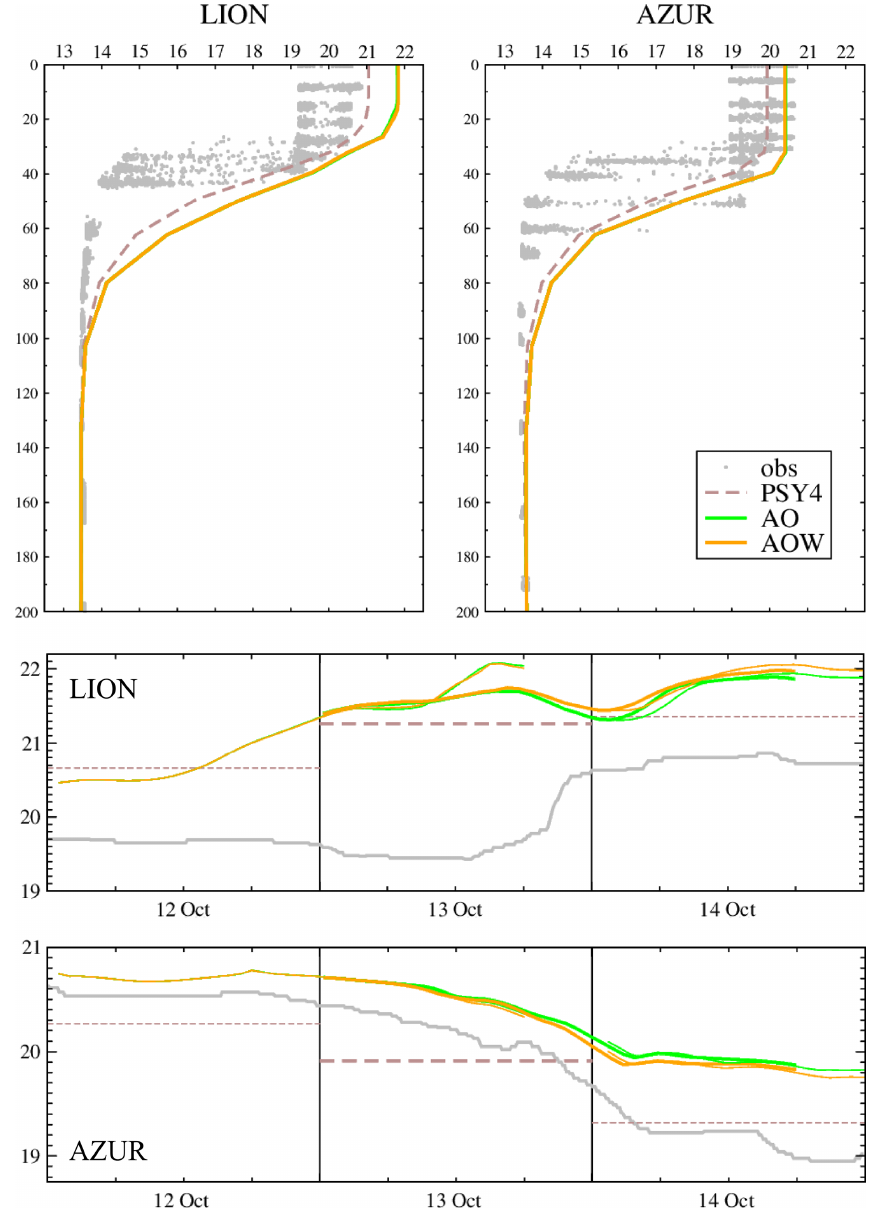
Figure 11. Upper panels: ocean temperature profiles ( ◦ C) observed by the chains of thermistors at the Lion (left) and Azur (right) buoys between 12 and 14 October (grey dots) and simulated by AO and AOW on average for the day of 13 October. Temperature profiles in the PSY4 operational system analysis of 13 October are shown in dashed lines. Lower panels: 6m depth ocean temperature time series ( ◦ C) observed at Lion and Azur and simulated by AO and AOW (successive forecasts). The dashed lines correspond to the values in